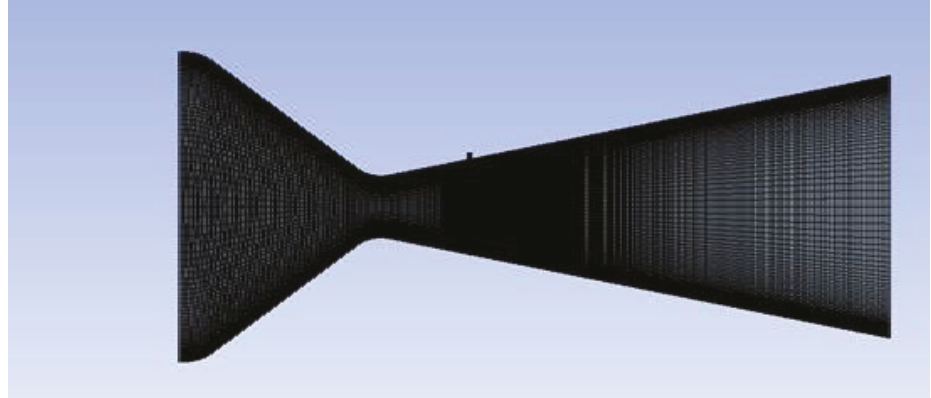
Figure 8: Computational structured grid 2.